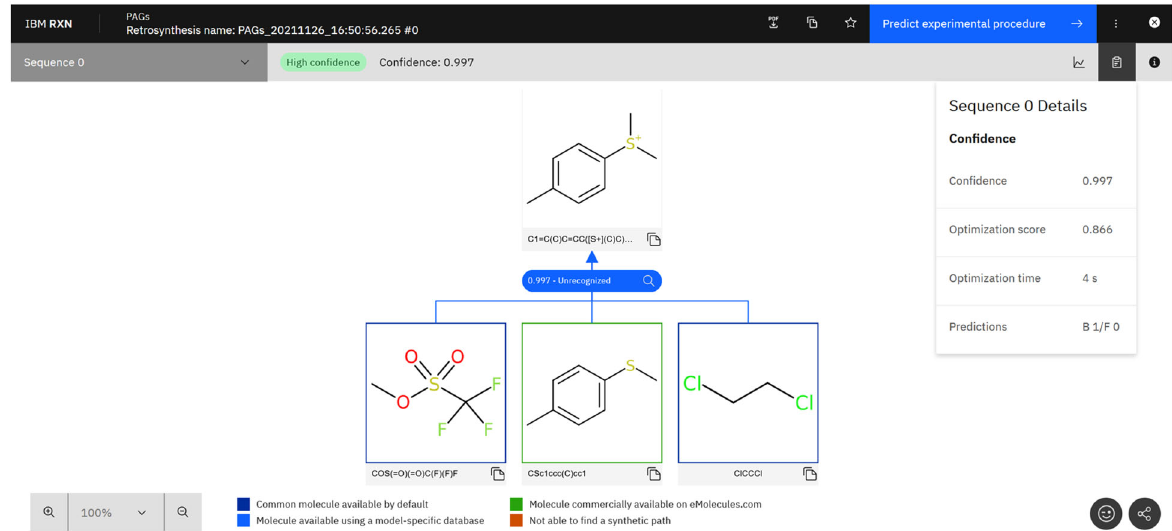
Fig. 9 Using IBM RXN to generate a reterosynthetic pathway for a target molecule. RXN determined that a one-step reaction involving the S-alkylation of 4-(methylthio)toluene by methyl tri fl uoromethanesulfonate would be the most promising pathway.